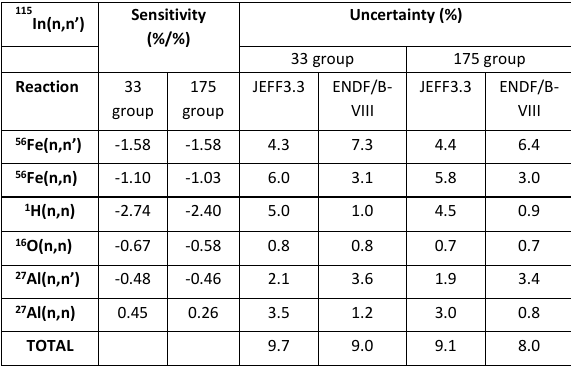
Table 1. Uncertainties in calculated 115 In(n,n’) detector reaction rates due to Fe, H, O and Al cross-section